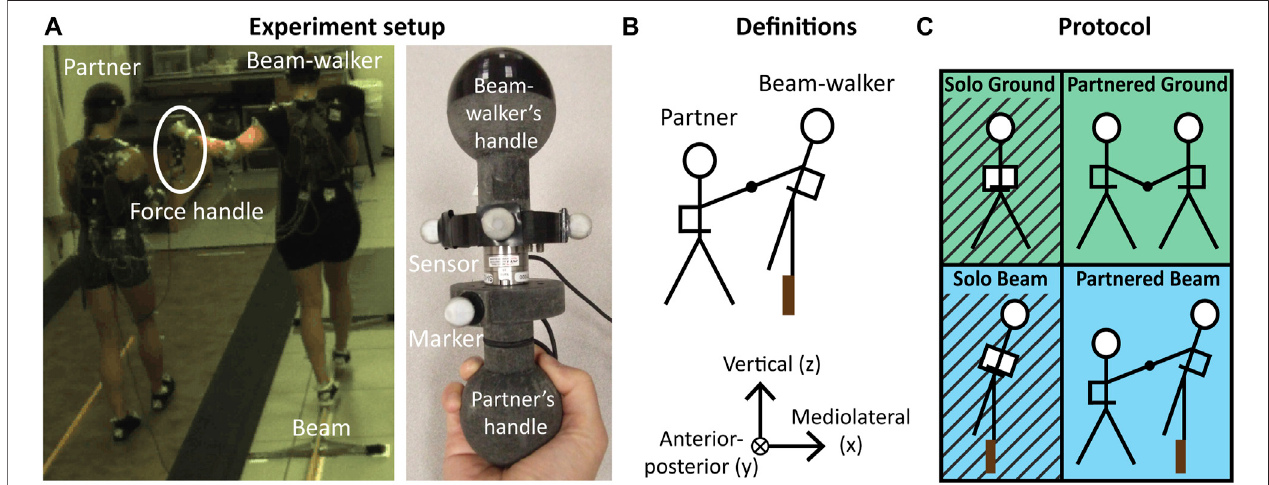
FIGURE 1 | Experiment setup and protocol. (A) partner and beam-walker during partnered beam-walking condition (left) and close-up of custom force handle device withsensorand motion capturemarkers(right). (B) Coordinateframede fi nition. (C) Experimentprotocol compares Solovs. Partnered Beam-walkingtoexamine effects of assistance on balance performance and Partnered Overground vs. Beam walking to examine the mechanics of assistance.